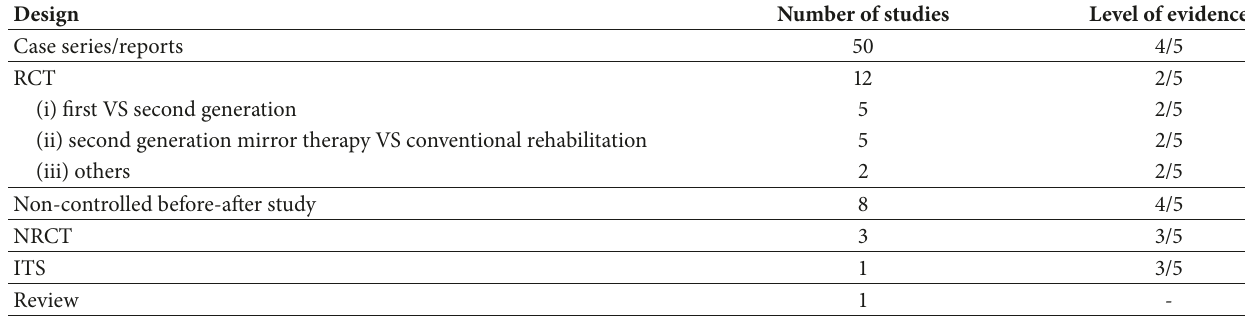
Table 19: Level of evidence according to The Oxford 2011 Levels of Evidence